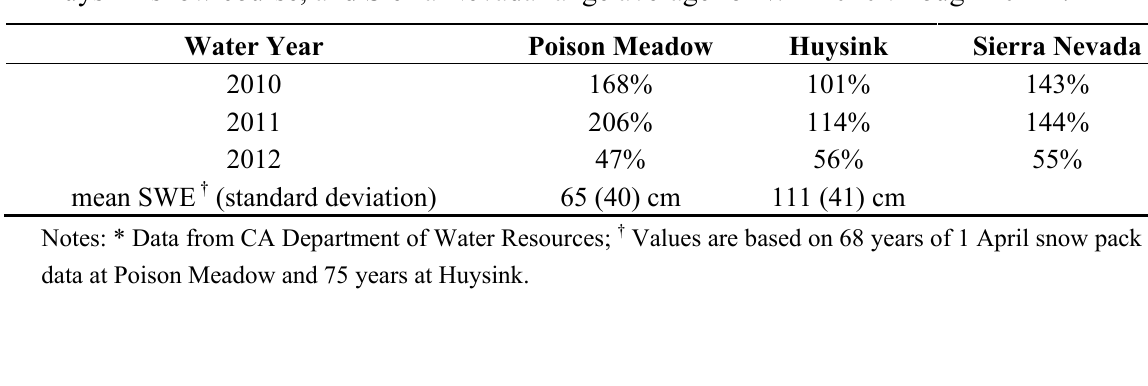
Table 2. Percentage of mean April 1 snow pack SWE for Poison Meadow snow course, Huysink snow course, and Sierra Nevada range average for WY 2010 through